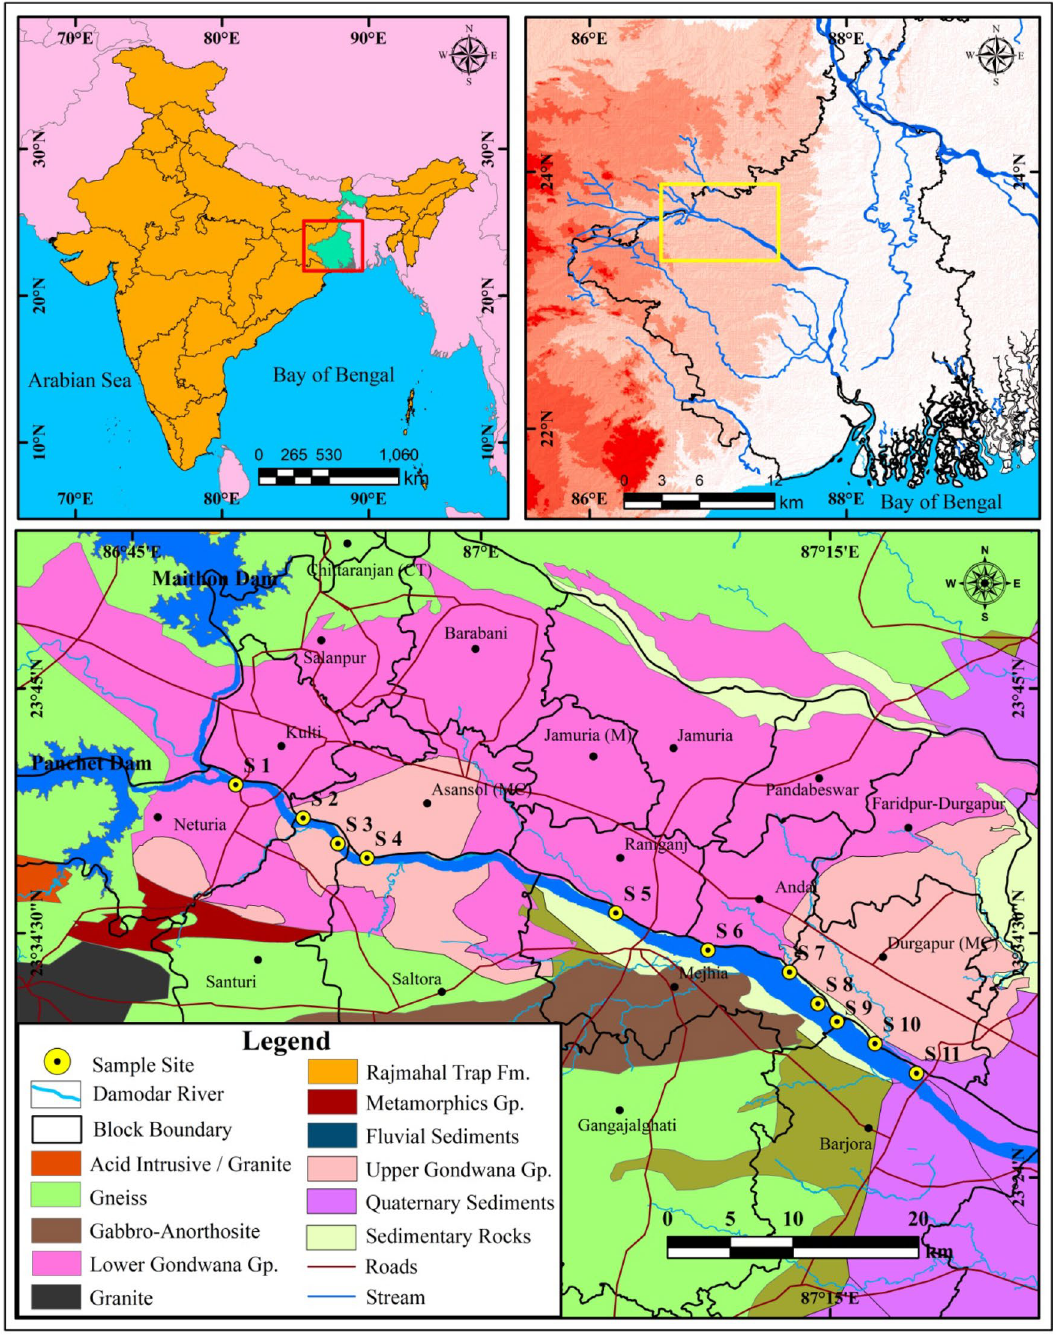
Figure 1. Location map of the study stretch of a tropical river Damodar (India). The diagram is prepared by open source QGIS 3.16 software (https:// qgis. org/ en/ site/ forus ers/ downl oad.